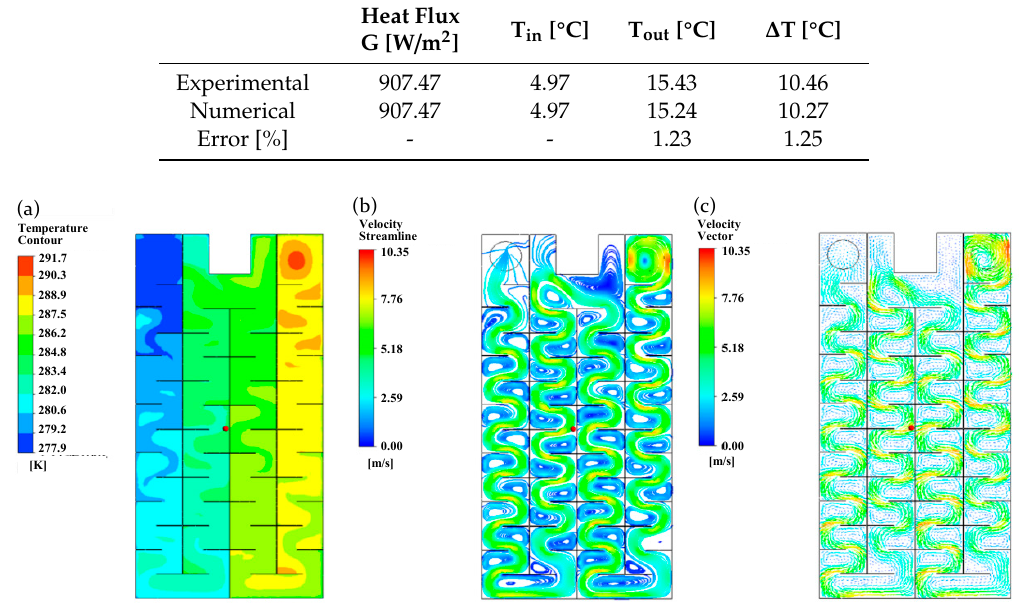
Figure 4. Baseline PVT air ba ffl e CFD model valification. ( a ) Temperature contour; ( b ) Streamlines and ( c ) Velocity